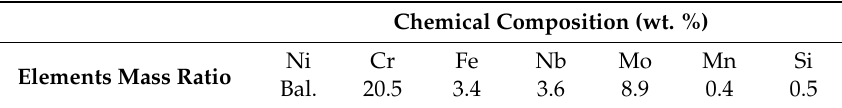
Table 1. Chemical compositions of the initial